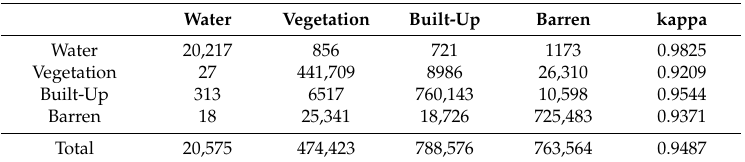
Figure 5. Comparison of LULC maps for Lahore and Peshawar for 2013, predicted using the CA-Markov model with the satellite-derived LULC maps. Table 6. Overall kappa statistic between each class of satellite-derived LULC maps and CA-Markov estimated maps for 2013 in Lahore city.